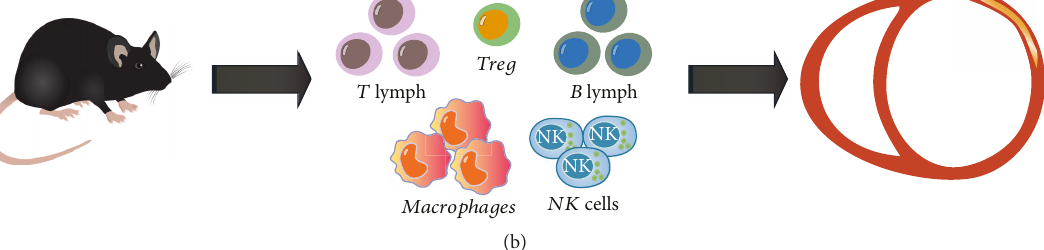
Figure 1: Role of Gal-1 in acute myocardial infarction. (a) Gal-1 is constitutively expressed in cardiomyocytes close to sarcomeric actin and is increased and secreted after acute myocardial infarction (AMI), in fl ammation, and hypoxia. (b) Mice lacking Gal-1 ( Lgals1 − / − ) show adverse ventricular remodeling after AMI associated with increased in fl ammation and reduced proportion of regulatory T (Treg)